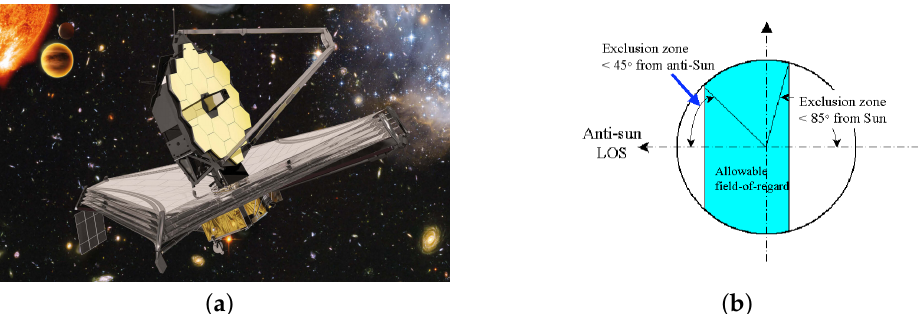
Figure 1. ( a ) The James Webb Space Telescope artist rendition. Source: European Space Agency. ( b ) JWST Field of Regard with two exclusion zones [3].